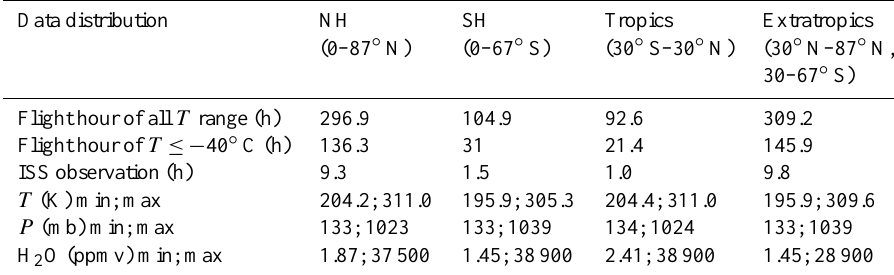
Table 1. Data distribution and sampling range in this